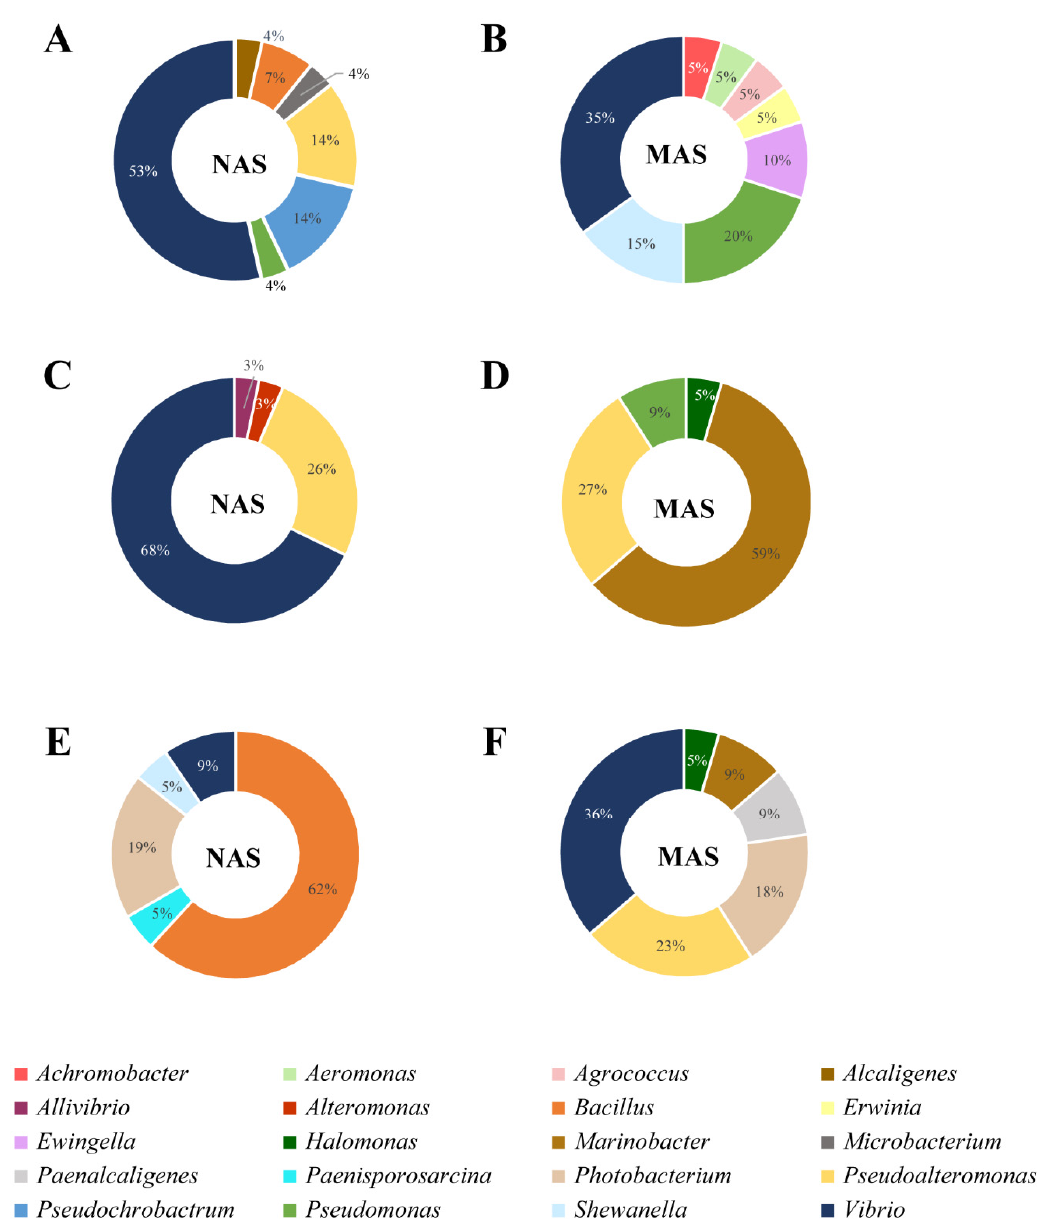
Figure 5. Representation of the bacterial genera (percentage) in: ( A )—European seabass skin swab samples from the NAS and ( B )—the MAS farm; ( C )—in seawater samples from the NAS farm and ( D )—the MAS farm; ( E )—in sediment samples from the NAS farm and ( F )—the MAS farm. V. toranzoniae was identified in European seabass swab samples and in